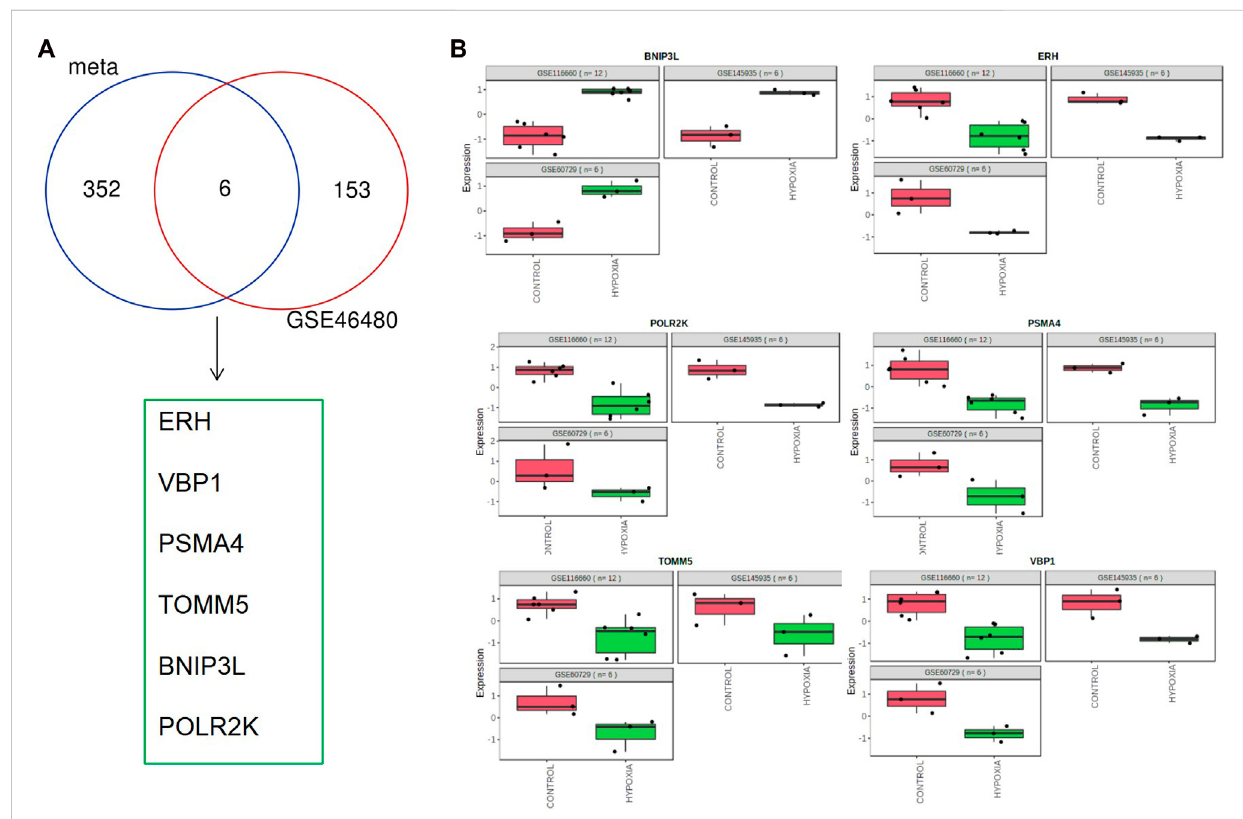
FIGURE 6 Common differentially expressed genes in meta-analysis and GSE46480. (A) Venn diagram of differentially expressed genes identi fi ed from the meta-analysis and GSE46480. (B) Scatter plots of common differentially expressed genes in the three GEO datasets for meta-analysis.